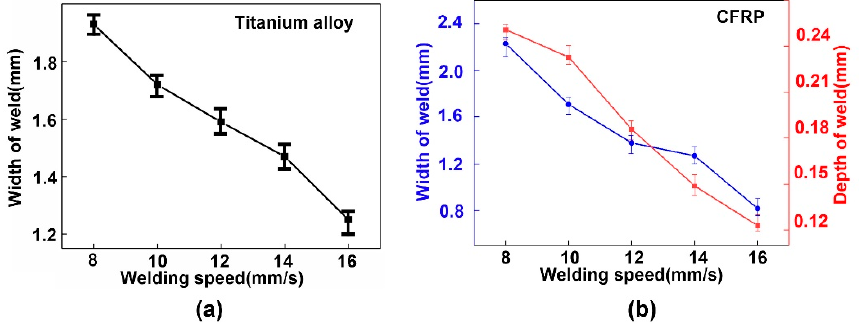
Figure 3. ( a ) Relationship between welding speed and the width of weld of Titanium alloy; ( b ) The effect of welding speed on width and depth of weld of CFRP. effect of welding speed on width and depth of weld of